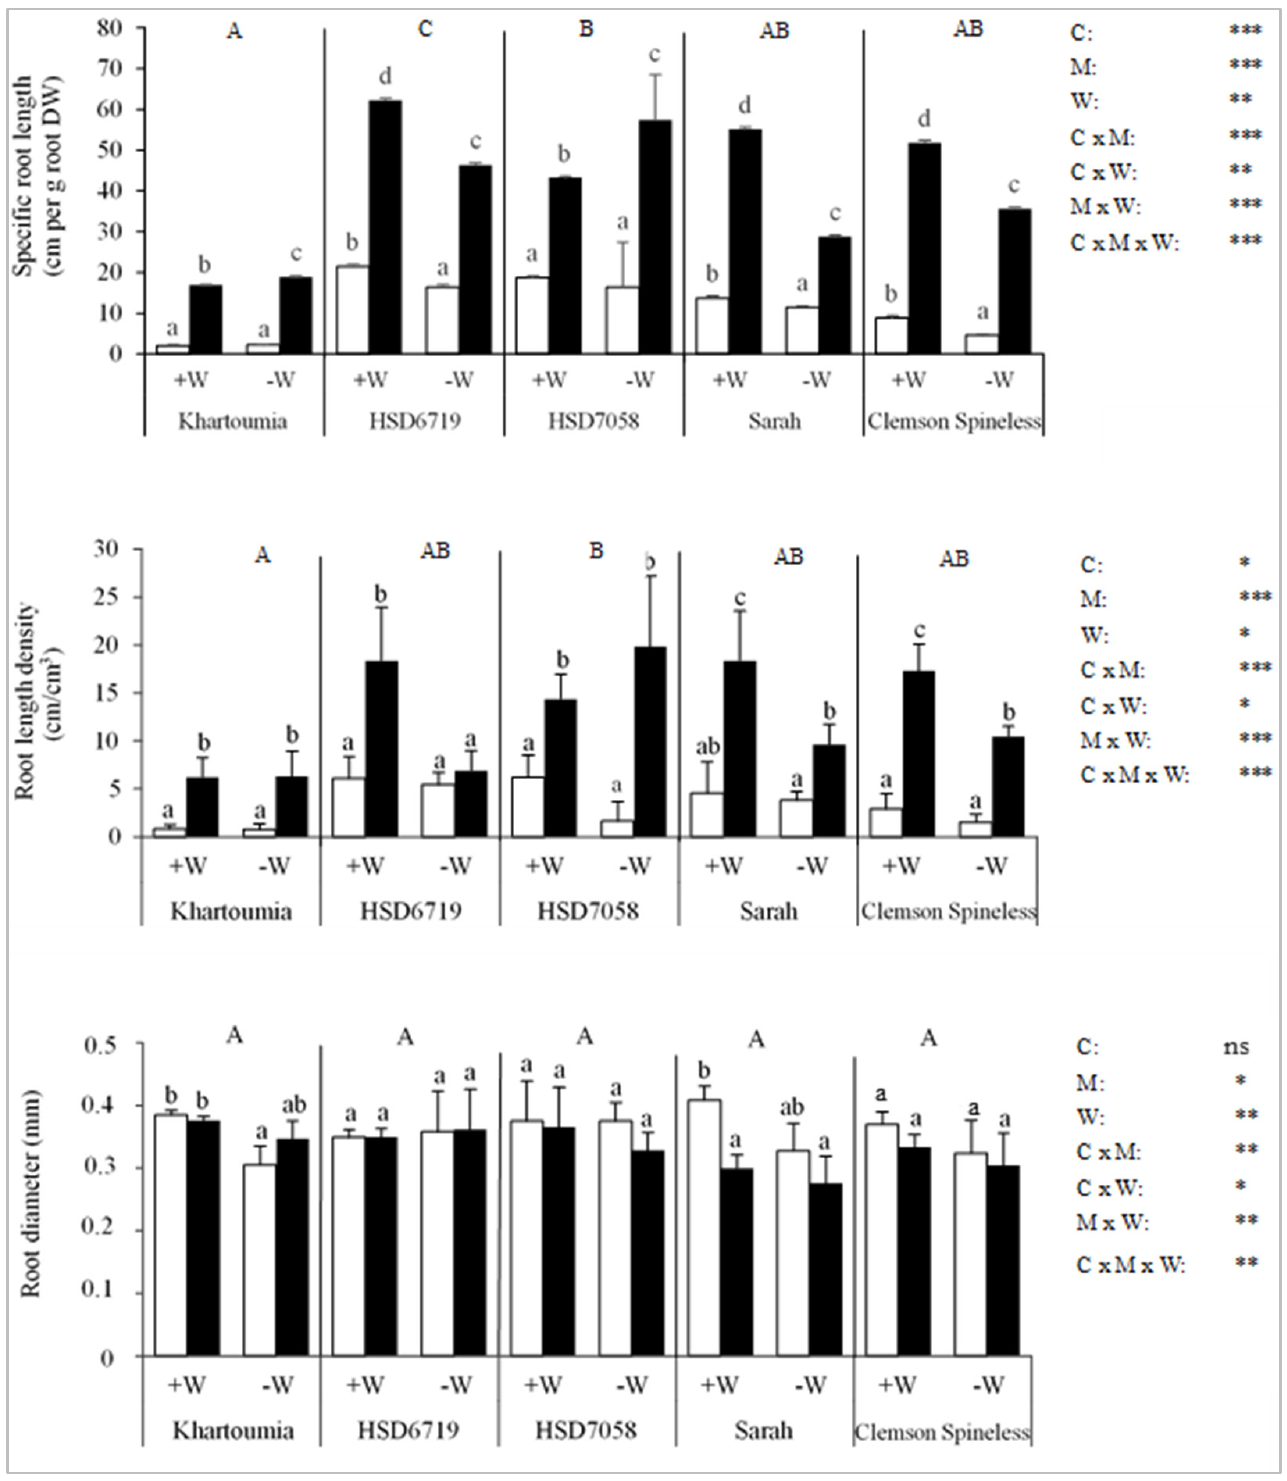
Figure 6. Specific root length ( upper ), root length density ( middle ) and root diameter ( lower ) in the five okra cultivars. For definitions of treatments and statistics, refer to the text for Figure 4.